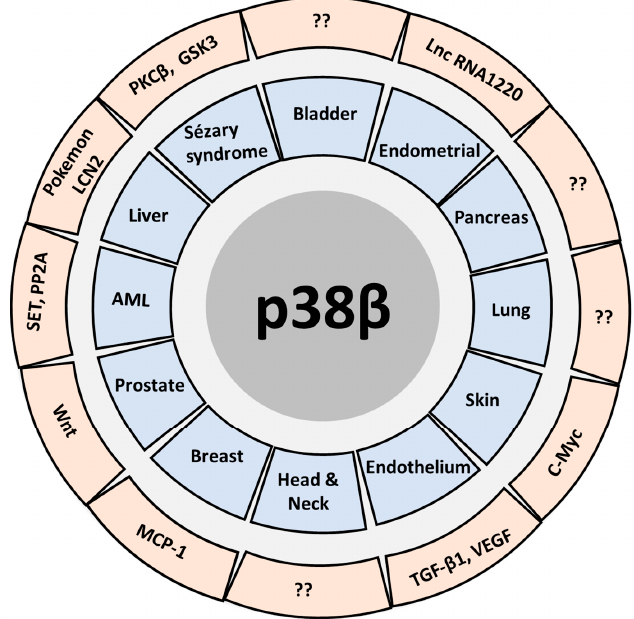
Figure 1. Schematic representation of the involvement of p38 β in different types of tumors (blue) and the related molecules (red).